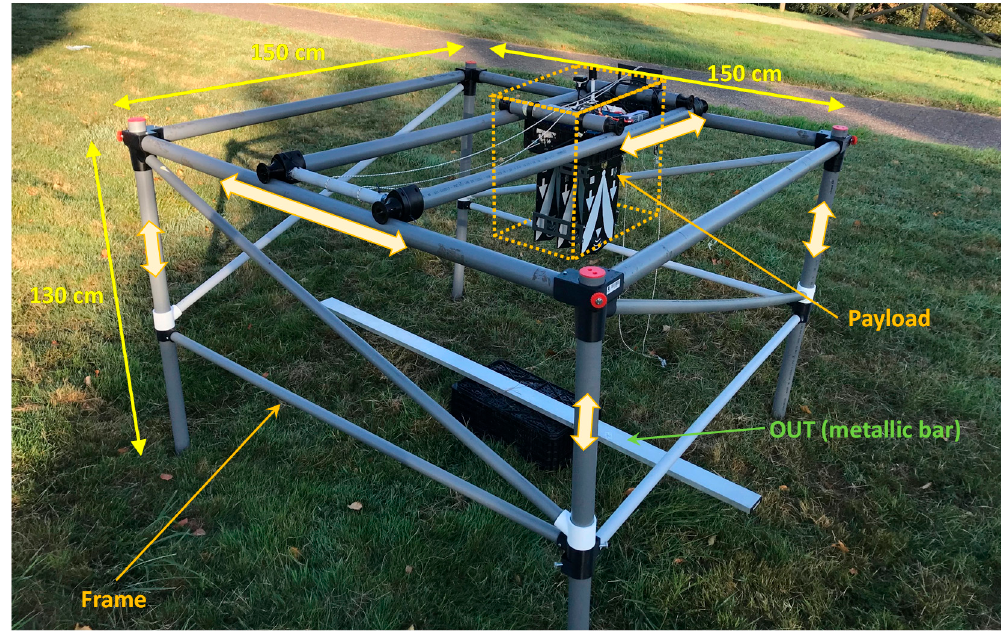
Figure 1. Picture of the portable setup for air-launched Ground Penetrating Radar (GPR) imaging.